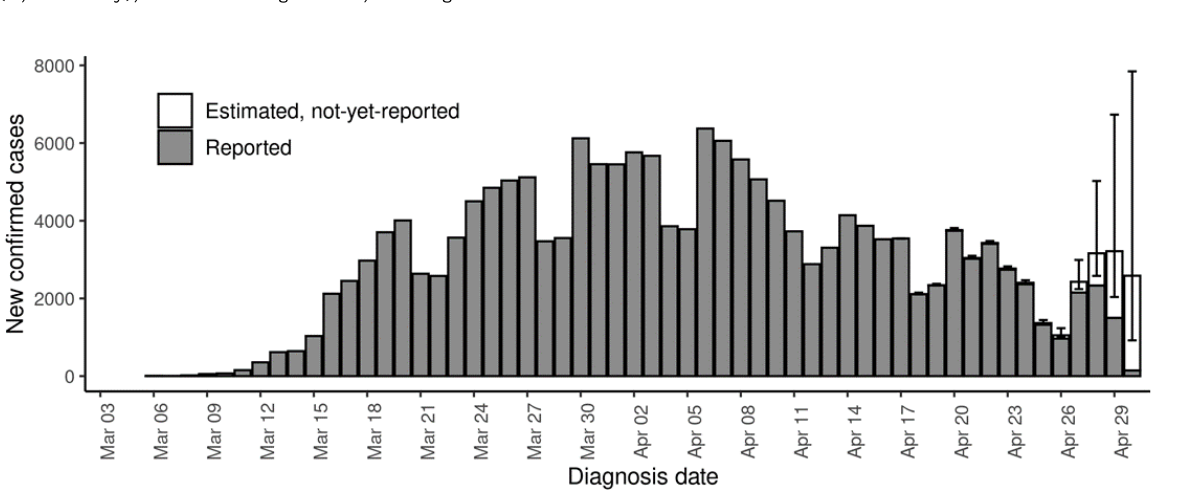
Figure 1. Example hindcast visualization of epidemic curve of reported and estimated but not-yet-reported number of confirmed cases among New York City residents diagnosed with COVID-19, from March 1 to April 30, 2020. Illustrative hindcast performed using cases reported through April 30, 2020 (ie, a Thursday), a 2-week moving window, and a negative binomial distribution.